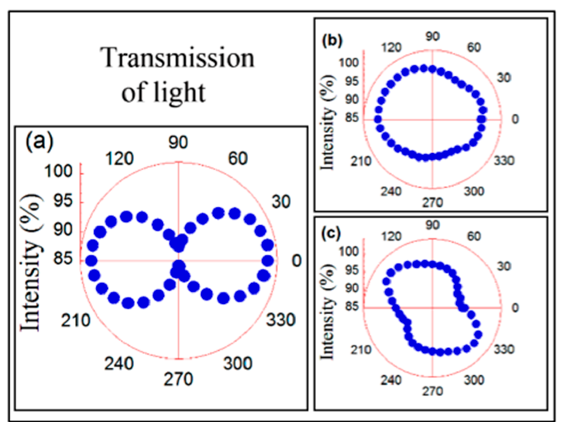
Figure 5. Polar plots of the transmitted intensity of polarized light for the obliquely deposited Co samples: ( a ) as-deposited; ( b ) 270 °C annealed and ( c ) 450 °C annealed. The 0 angle value corresponds to the direction of polarization parallel to the nano-sheets direction.